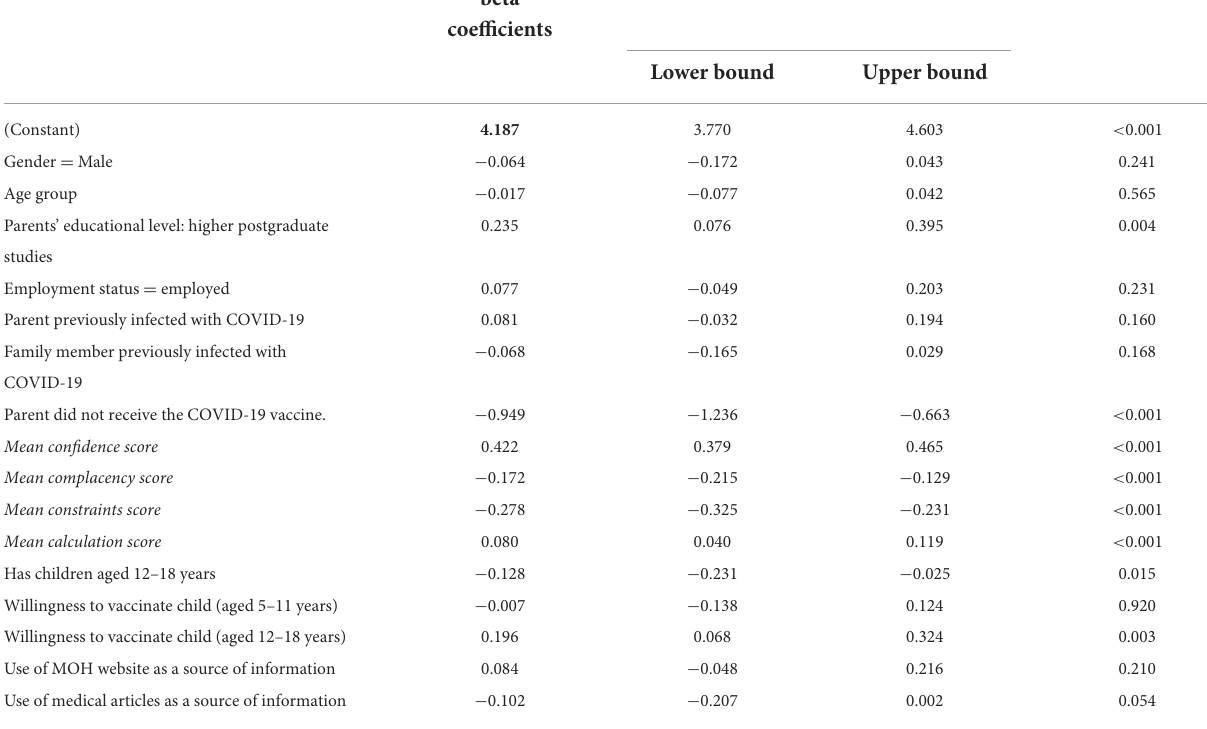
TABLE 5 Multivariate linear regression analysis of parents’ collective responsibility as scored by the 5C